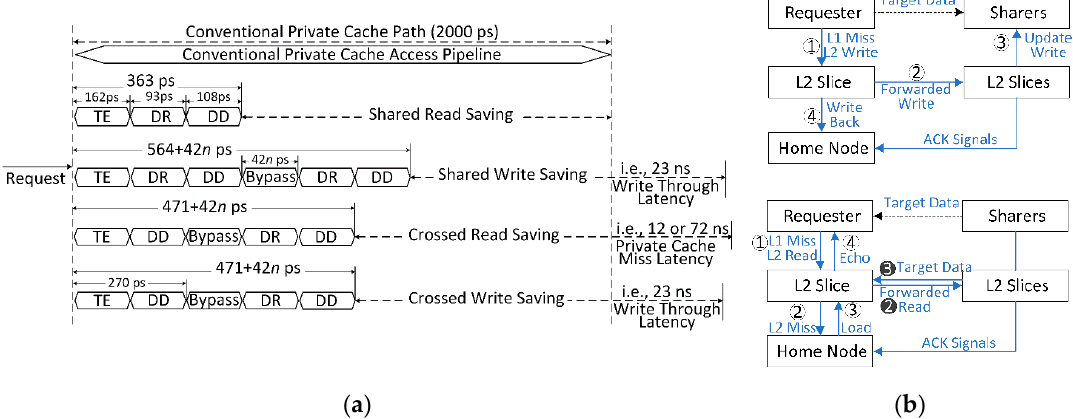
Figure 8. ( a ) Access paths of four access patterns including shared read/write accesses and crossed read/write accesses, while approximate access latency values of proposed path and conventional path are compared. Where 42 n stands for the latency of bypassing n routers and n is less than or equal to six for XY routing in a 4 × 4 router network; ( b ) Data exchange examples on proposed path and conventional path, where dashed line stands for data routing in proposed network and dark-filled steps represent directory based coherence path.